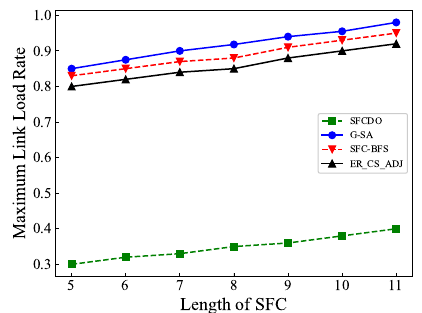
Figure 12. Maximum link load rate of SFCs in large